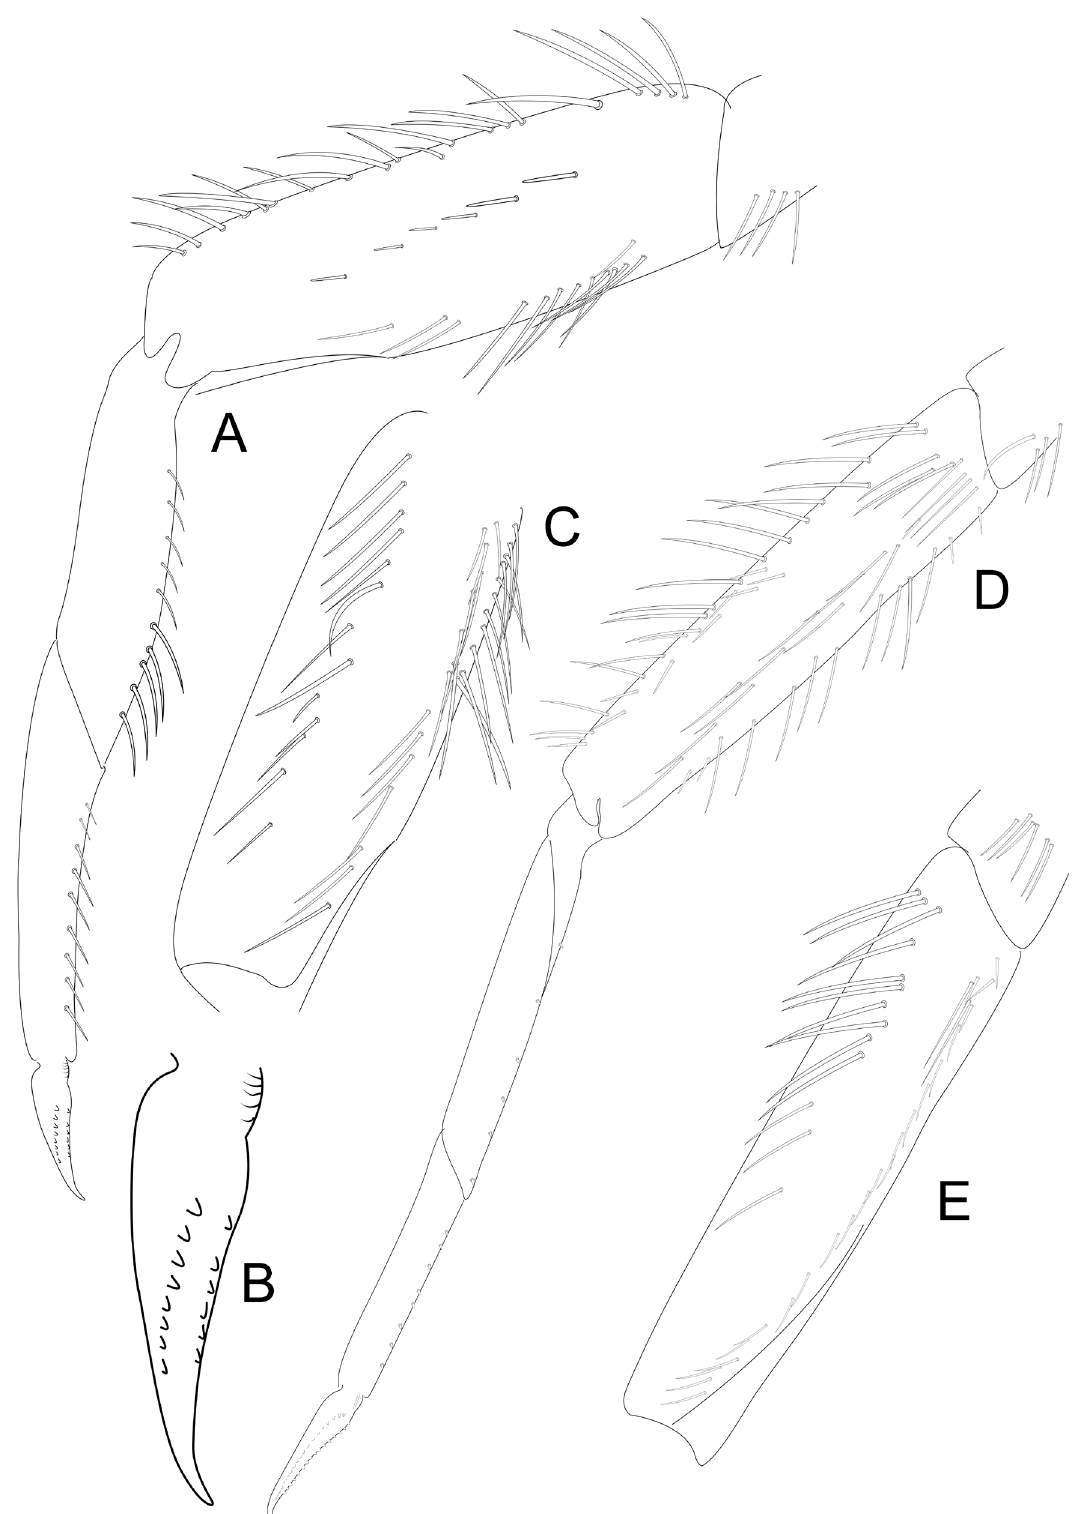
Fig. 2. Rivudiva trichobasis Lugo-Ortiz & McCafferty, 1998, paratype (IBN slide #270). A . Foreleg (femur on anterior surface). B . Detail of fore claw. C . Posterior surface of forefemur. D . Hind leg. E . Posterior surface of hind femur. Not to